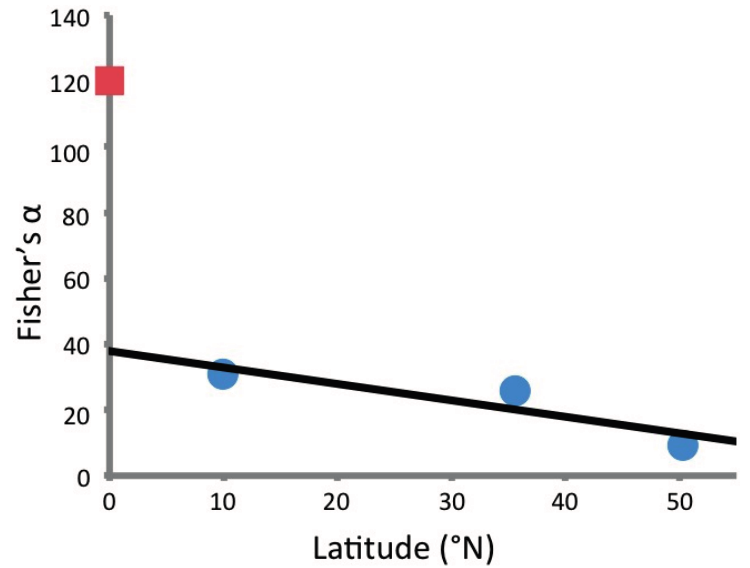
Figure 2. Fisher’s α versus latitude of Ecuadorian stem-inhabiting endophytes (red square) and foliar endophytes collected from angiosperms by Arnold and Lutzoni in 2007 [4] (blue